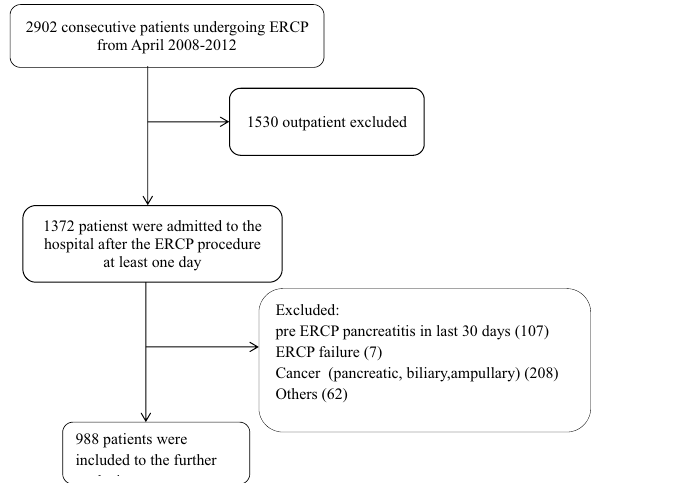
Figure 1. Inclusion flowchart of the